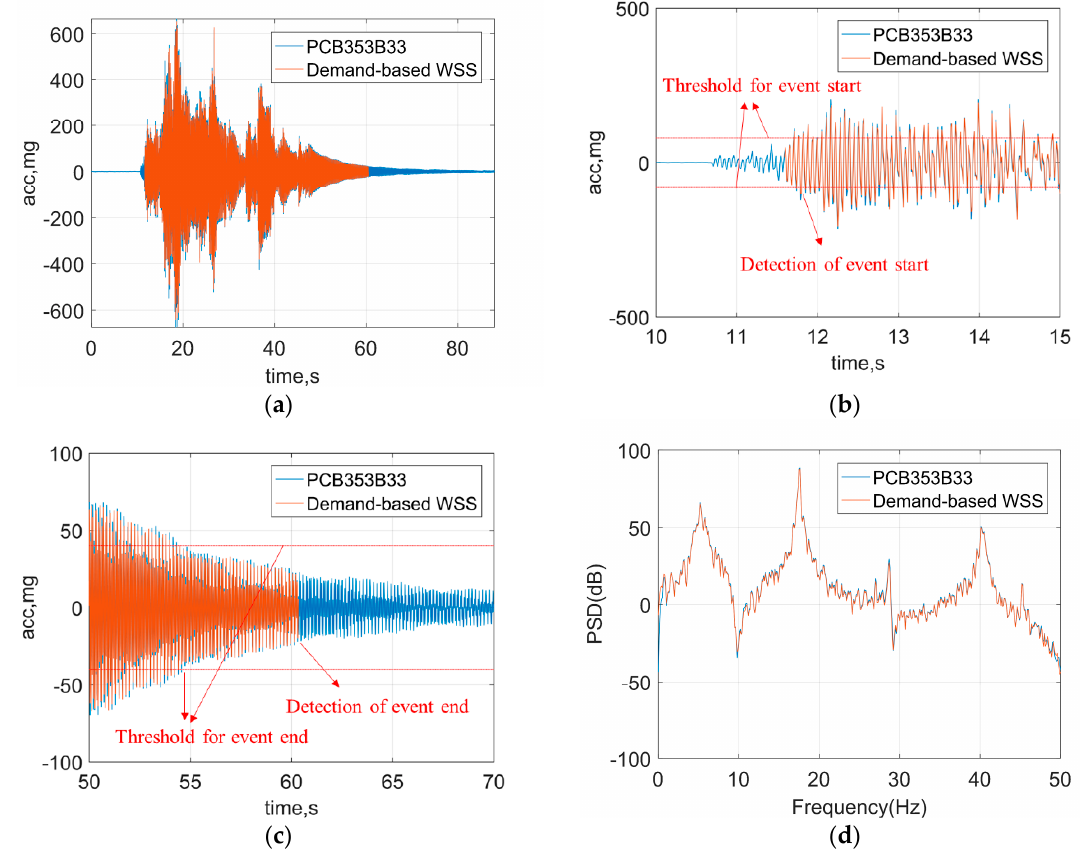
Figure 9. Test results of earthquake monitoring: ( a ) time history data, ( b ) zoomed view of time history data for event start, ( c ) zoomed view of time history data for event end, ( d ) power spectral density (PSD) data.